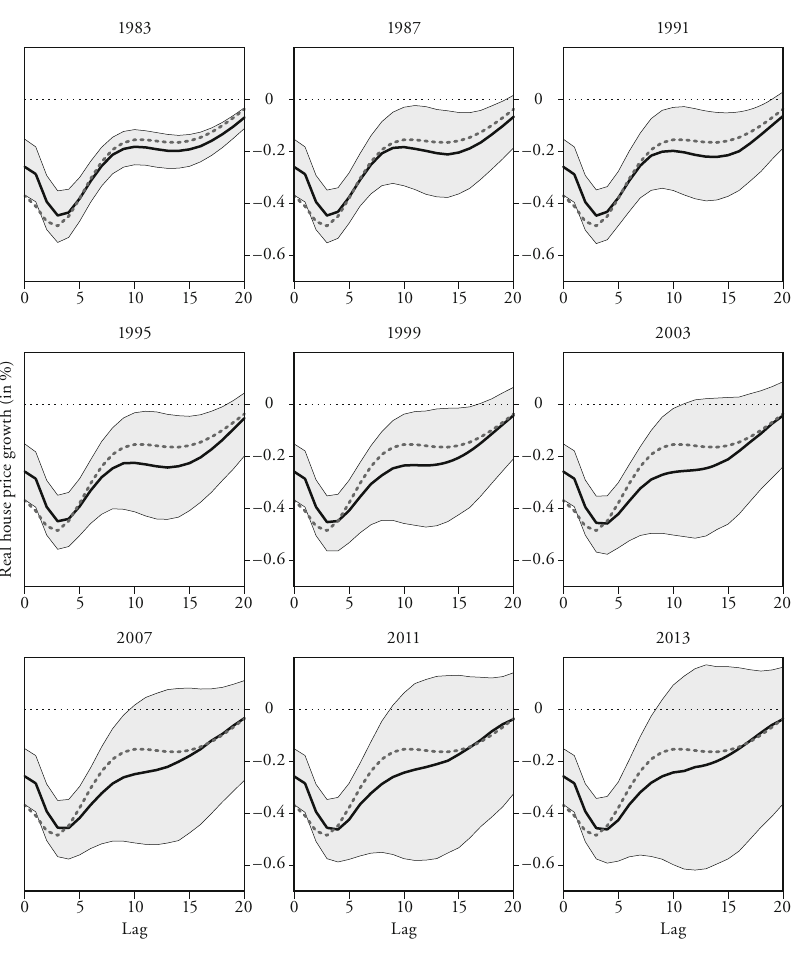
Figure 10: Response of House Prices to a Shock on GDP